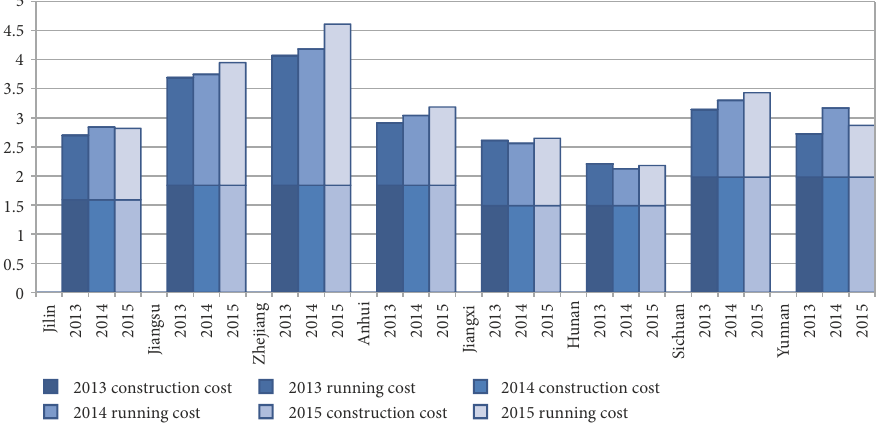
Table 4. Discharged and treatment of industrial waste water